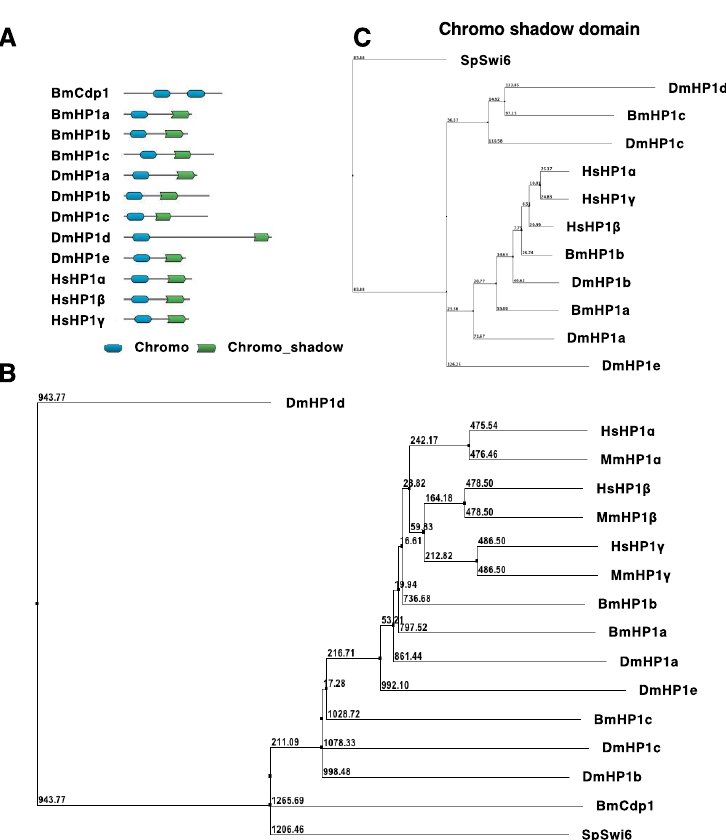
Figure 1. ( A ) Domain search of HP1 of various organisms ( Bombyx mori , Drosophila melanogaster , Homo sapiens ). ( B ) Phylogenetic tree of HP1 of various organisms ( Bombyx mori , Drosophila melanogaster , Homo sapiens , Mus musculus , Schizosaccharomyces pombe ). ( C ) Phylogenetic tree of chromo shadow domain which HP1s of various organisms have ( Bombyx mori , Drosophila melanogaster , Homo sapiens, Schizosaccharomyces pombe ).